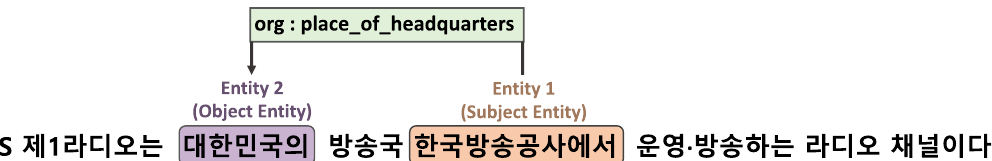
Figure 1. Example of Korean RE. The translation of the sentence in Korean is “KBS 1 Radio is a radio channel operated and broadcasted by the Korea Broadcasting Corporation (Entity 1) in South Korea (Entity